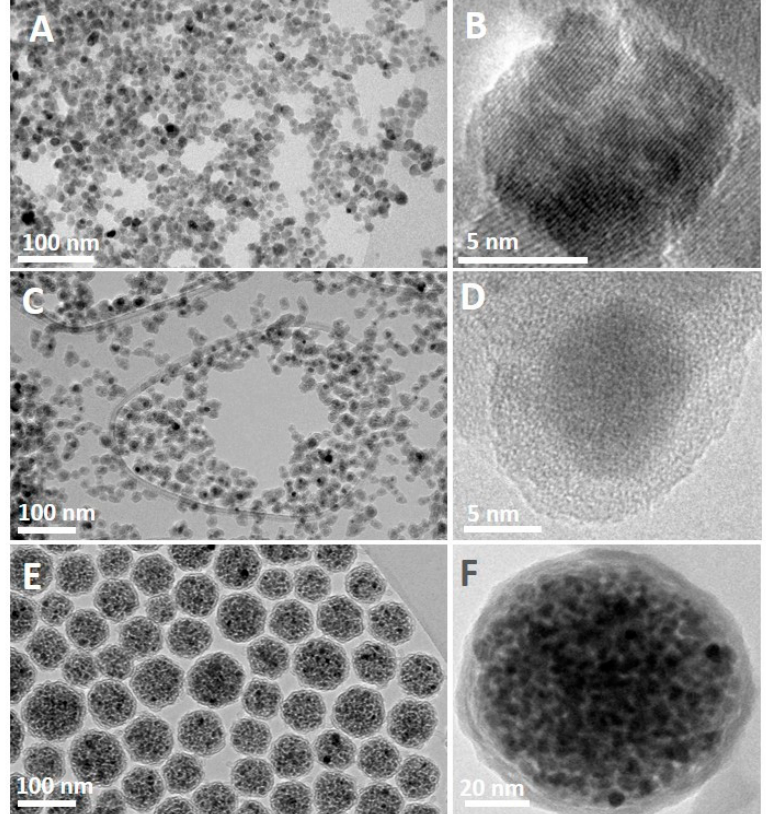
Figure 1. ( A , B ) Transmission electron micrographs of studied nanoparticles: superparamagnetic iron oxide nanoparticles (SPIONs), ( C , D ) silica-encapsulated individual nanoparticles (SPIONs-SIL), and ( E , F ) silica-encapsulated nanoparticle clusters (MNC).